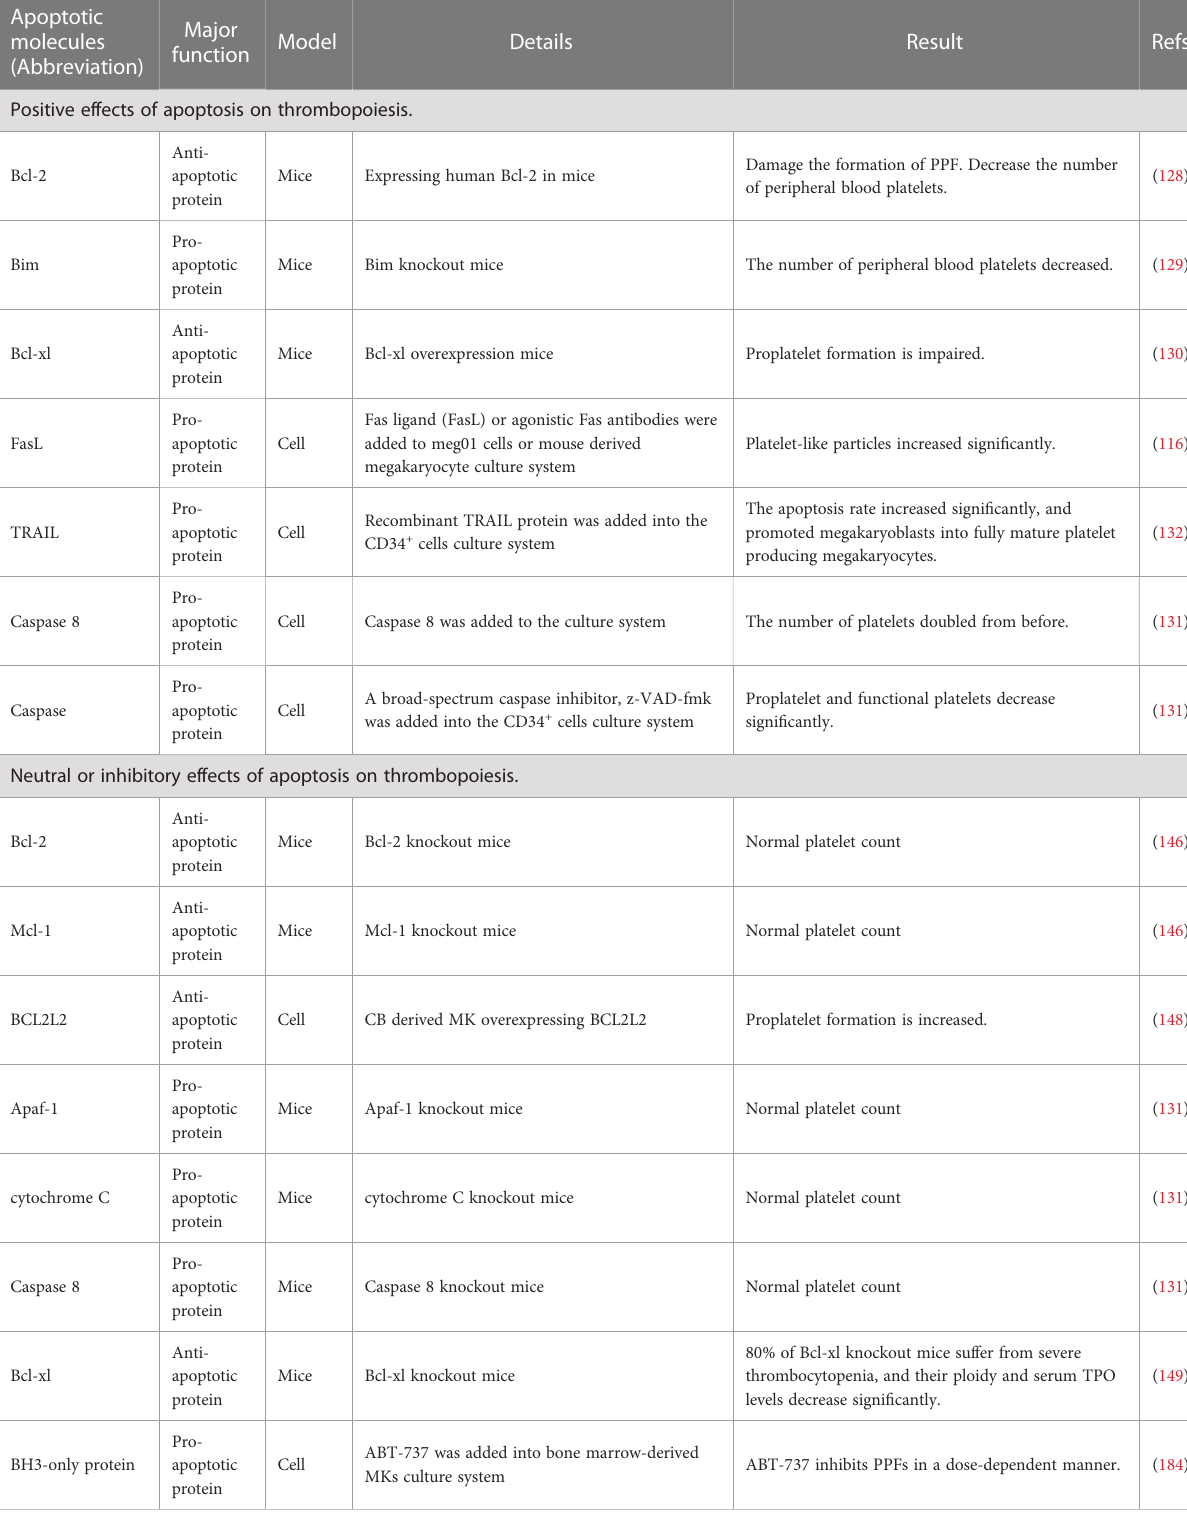
TABLE 1 The subtle relationship between thrombopoiesis and apoptosis-related molecules. Apoptotic Major molecules Model function (Abbreviation) Positive effects of apoptosis on